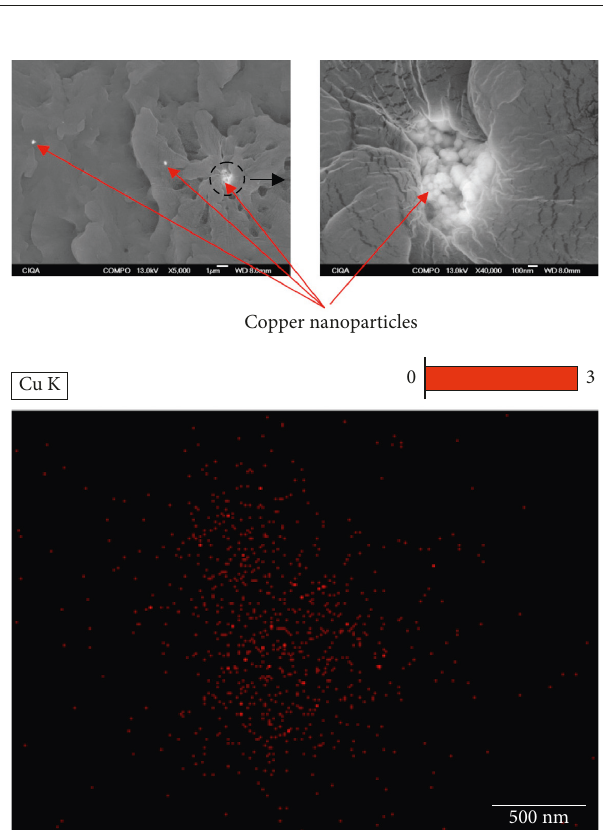
Figure 7: Copper elemental mapping by energy dispersive spec- troscopy (EDS).